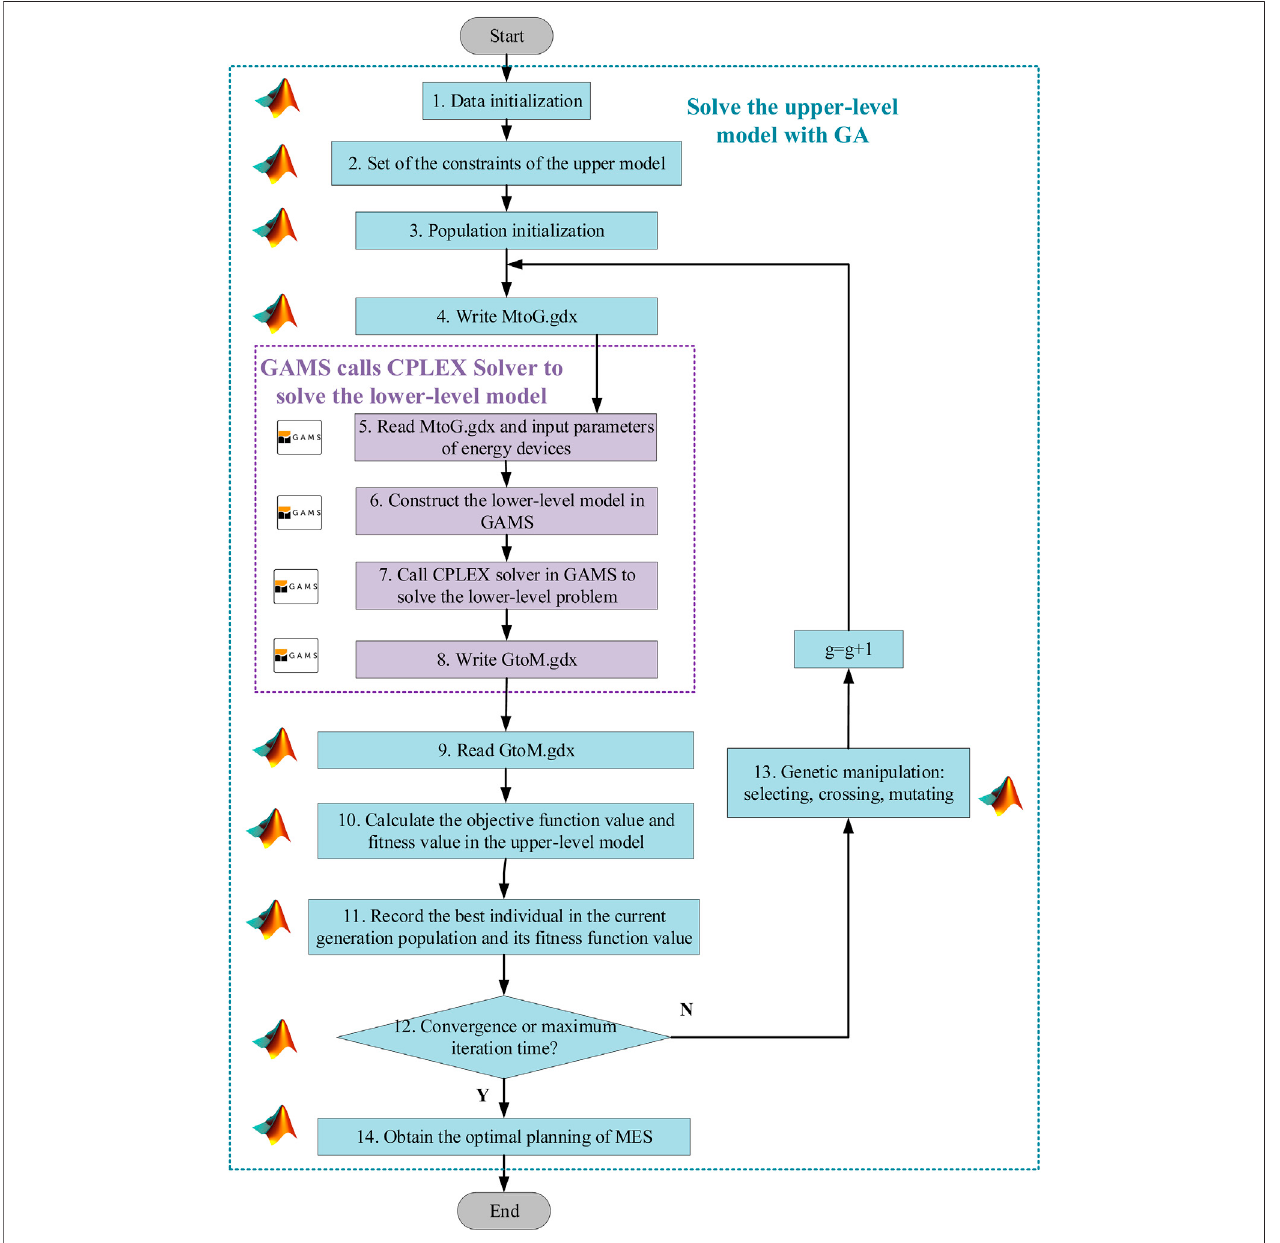
FIGURE 3 | Hybrid GCA – MILP algorithm fl